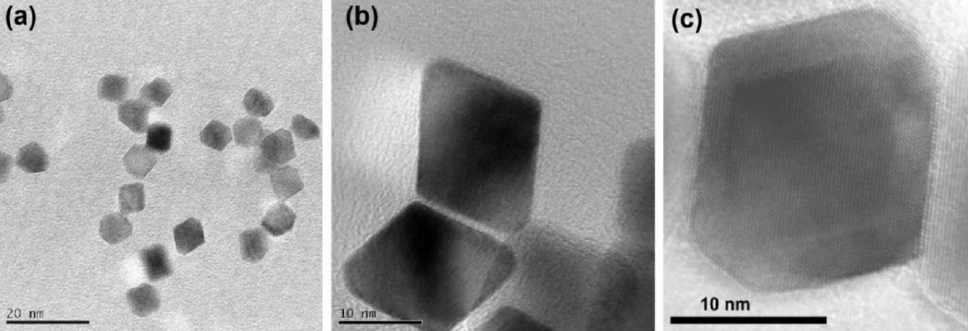
Figure 5. ( a ) Pt nanoparticles by modified polyol method [35], and ( b ) [42]. ( c ) Pt-Pd core-shell na- noparticles by modified polyol method; their nanostructures with the thin Pd shells with several Pd